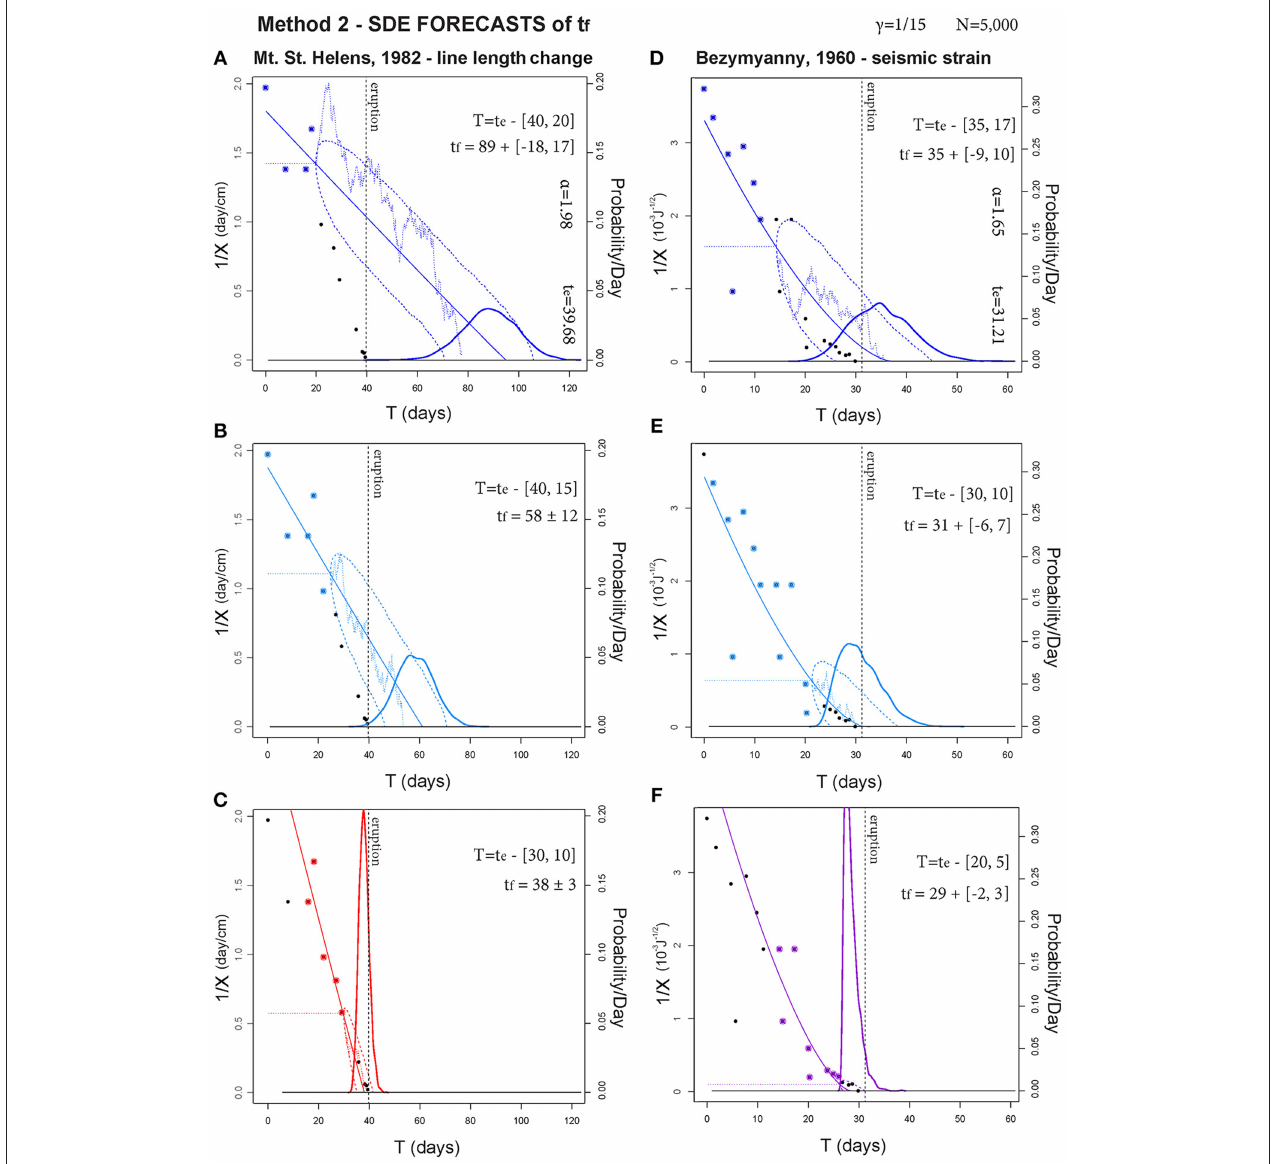
FIGURE 8 | Forecasts of t f based on Method 2. In (A–C) and (D–F) respectively, two examples are tested on three different time windows T . The bold line is g t dashed lines bound the 90 % confidence interval of the SDE paths, and a thin continuous line is the mean path. Thin dotted lines show examples of random paths. The points are inverse rate data, those in T are colored. A thin dashed line marks 1 / x 0 , and a dashed black line marks t e . The probability/day scale bar is related to g t